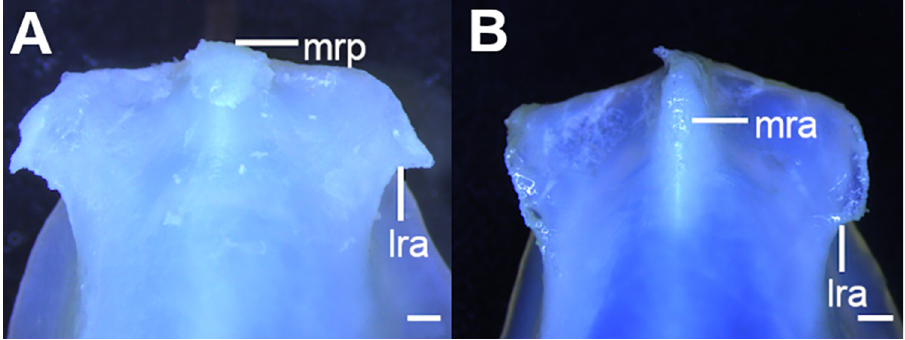
Fig 5. Detail of rostral process of Squalus species in ventral view, showing rostral appendages. A: S . albifrons , MZUSP 121272, adult male, 760 mm TL; B: S . montalbani , MZUSP121270, adult male, 713 mm TL. Abbreviations: lra: lateral rostral appendage; mra: medial rostral appendage; mrp: median rostral prominence. Scale bars: 1 mm.